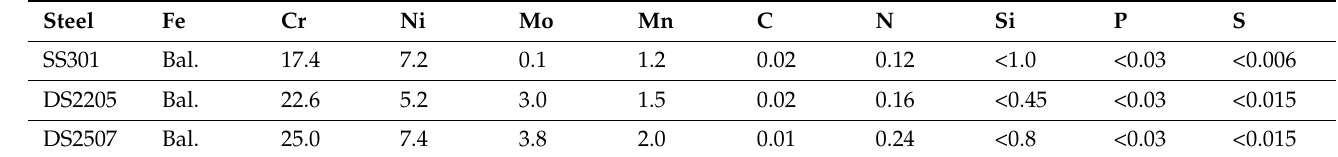
Table 1. Chemical composition of SS301 and duplex stainless steels 2205 and 2507 (in